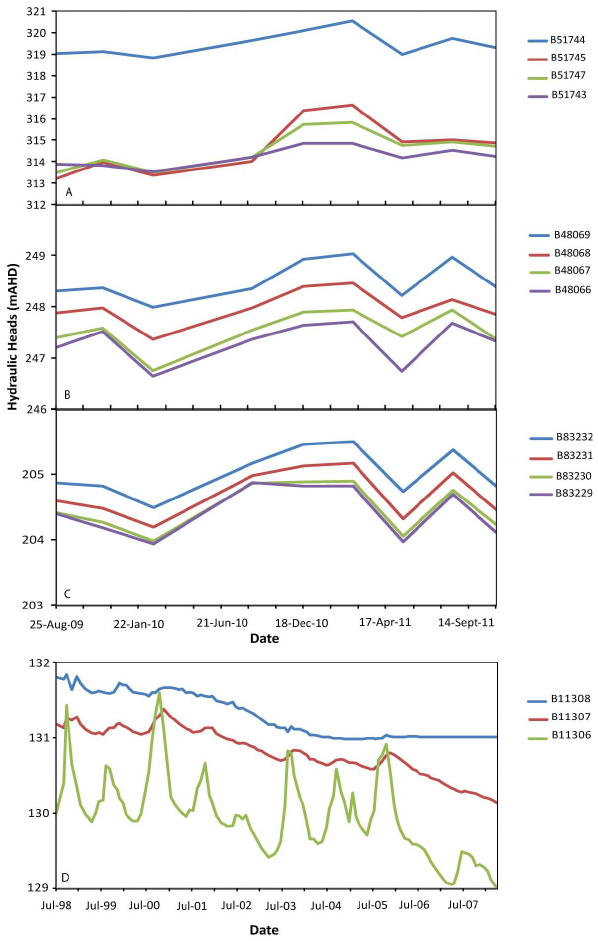
Fig. 3. Seasonal variation in bore hydrographs at (A) Bright in the upper catchment, (B) Eurobin and (C) Myrtleford in the middle catchment, and (D) Peechelba in the lower catchment (Victorian Water Resource Data Warehouse, 2011). Bores are listed in order of decreasing distance from the river. Annual head variations and hy- draulic gradients toward the river in the catchment decrease down- stream. mAHD (m Australia Height Datum) refers to metres above mean sea level.